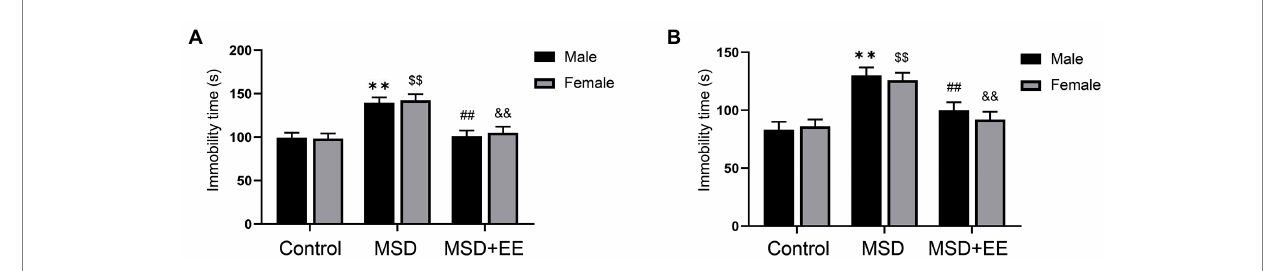
FIGURE 2 Effects of an environmental enrichment (EE) on depression-like behavior in elderly offspring mice exposed to maternal sleep deprivation (MSD). (A) Immobility time in the forced swimming test. (B) Immobility time in the tail suspension test. ** p < 0.01 vs. Control group in males; $$ p < 0.01 vs. Control group in females; ## p < 0.01 vs. MSD group in males; && p < 0.01 vs. MSD group in females.